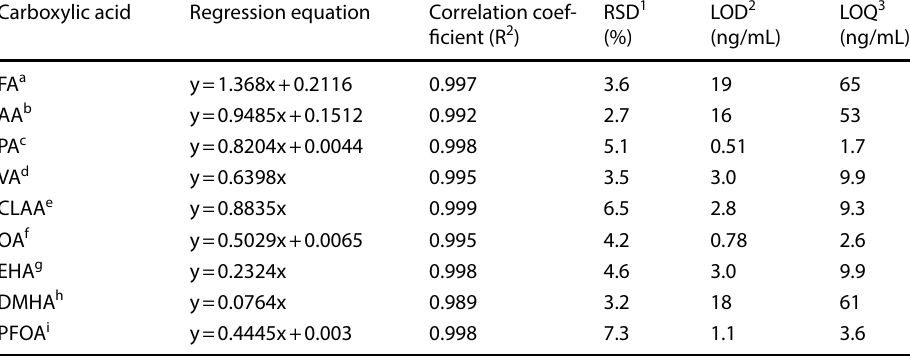
Table 3 Quantitative calibration and detection limits